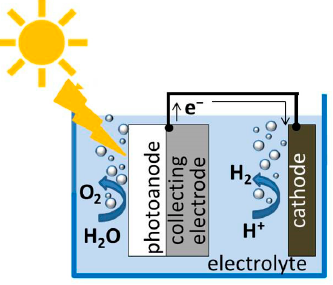
Figure 7. Schematics of a photoelectrochemical cell for water-splitting. The light impinging on the photoanode generates hole and electron pairs; the first migrate to the surface and promote the oxygen evolution, while the second, after travelling to the cathode, drive the hydrogen evolution.